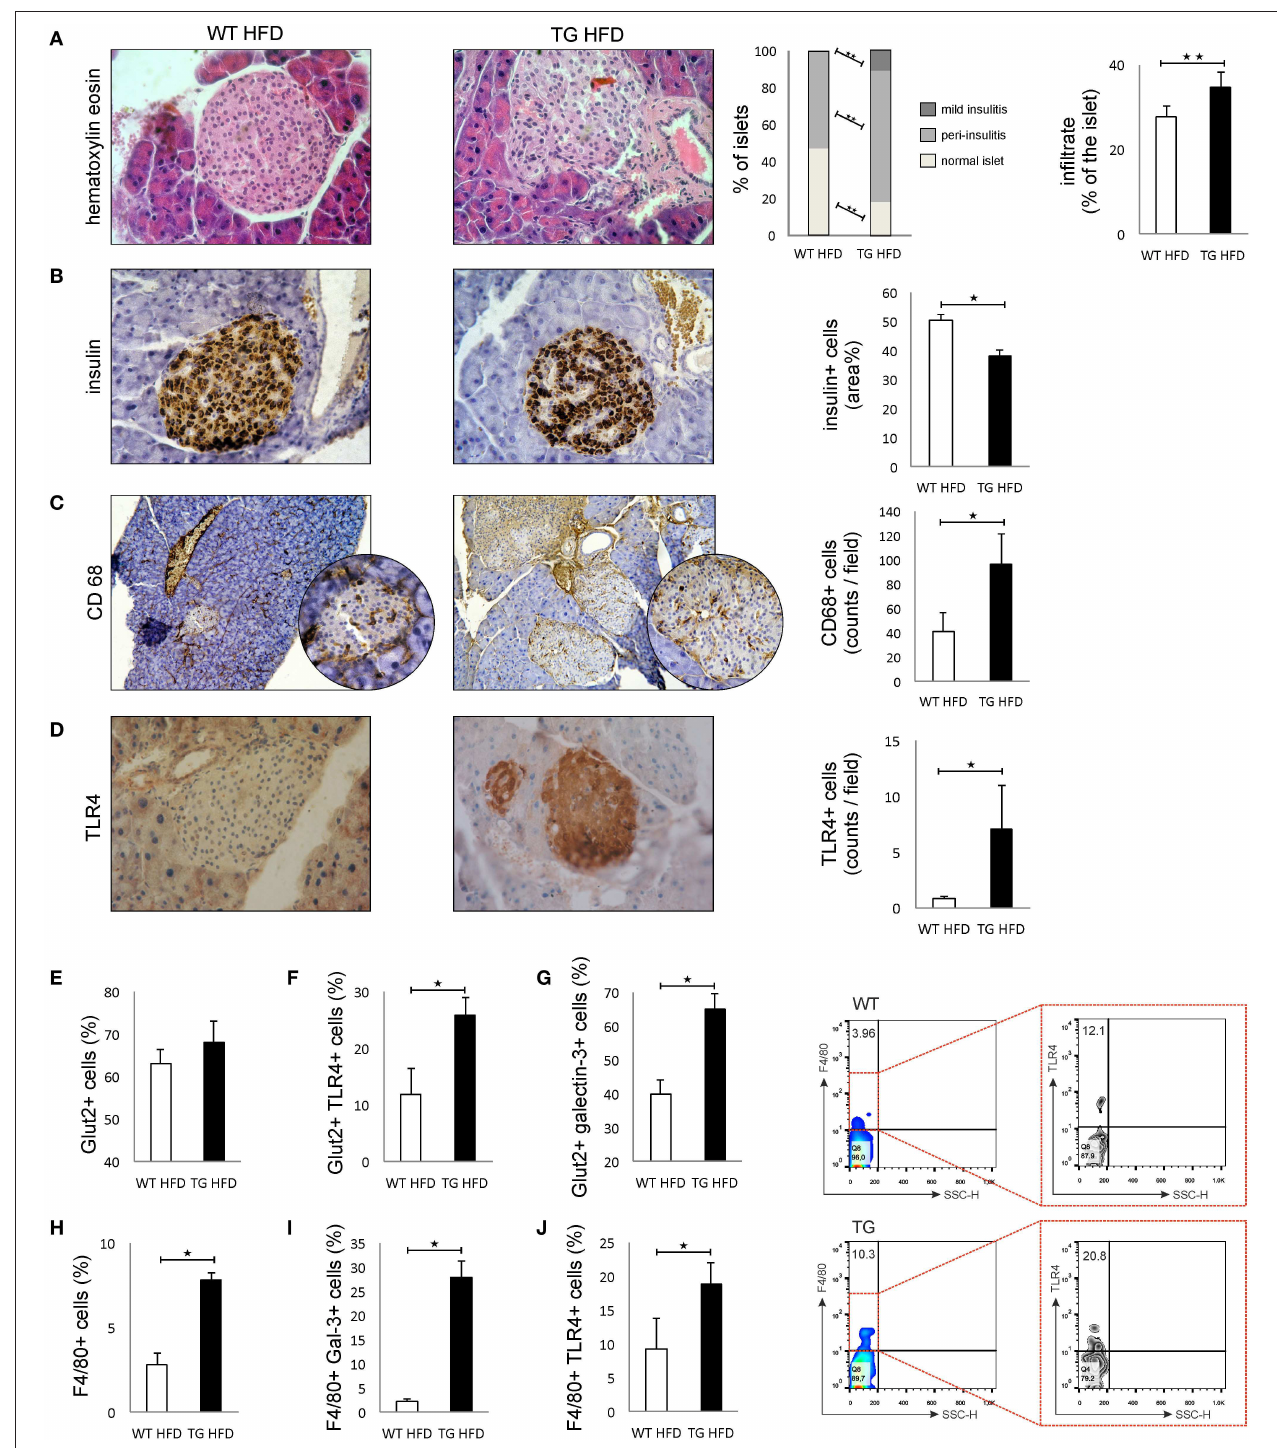
FIGURE 3 | Transgenically enhanced galectin 3 expression on β cells aggravates islet inflammation and increases TLR4 expression. Islet infiltration after 16 weeks of HFD feeding. Percentage of islets with peri-insulitis and mild insulitis was higher in TG mice, and the intensity of mononuclear cell infiltration in the islets was significantly higher in TG mice compared to WT (A) . Immunohistochemical expression of insulin + cells in islets. The percentage of insulin-positive islet area was significantly lower in TG mice (B) . Immunohistochemical expression of CD68 + cells in islets. A significantly higher number of CD68 + macrophages was observed in TG mice on HFD compared to WT mice (C) . Immunohistochemical expression of TLR4 + cells in islets. A significantly higher number of TLR4 + cells was observed in